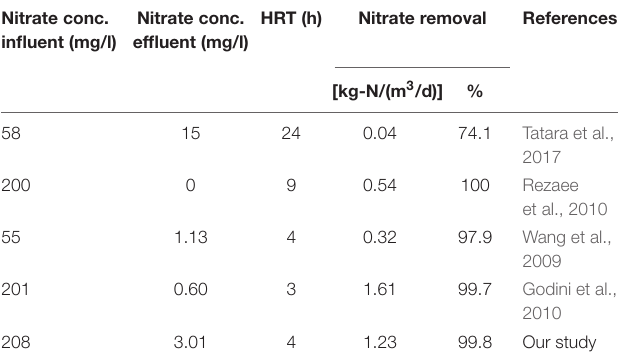
TABLE 4 | Comparison between the literature and our study of the rate and percent of nitrate removal in continuous moving bed bioreactor experiments with immobilized biomass.